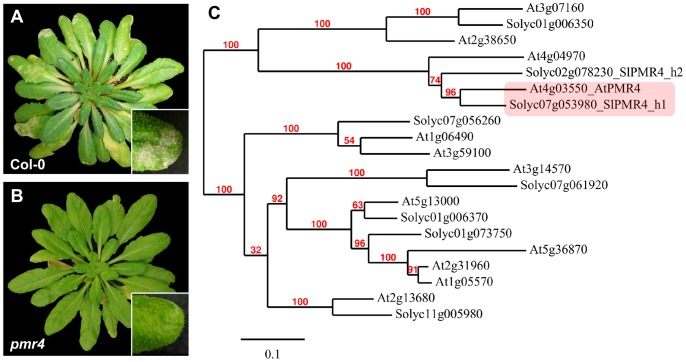
Impairment of PMR4 in Arabidopsis results in resistance to tomato powdery mildew Oidium neolycopersici.(A and B), Col-0 and pmr4 mutant plants photographed 14 days post inoculation with Oidium neolycopersici. Fungal sporulation is visible as whitish powder on multiple leaves of Col-0 but not on pmr4 mutants, showing that Arabidopsis PMR4 is a susceptibility (S) gene for O. neolycopersici. (C), Phylogenetic tree of Arabidopsis PMR4 family members plus tomato PMR4 family orthologs. The protein SlPMR4_h1 encoded by the tomato gene Solyc07g053980 is considered to be the tomato ortholog of AtPMR4.